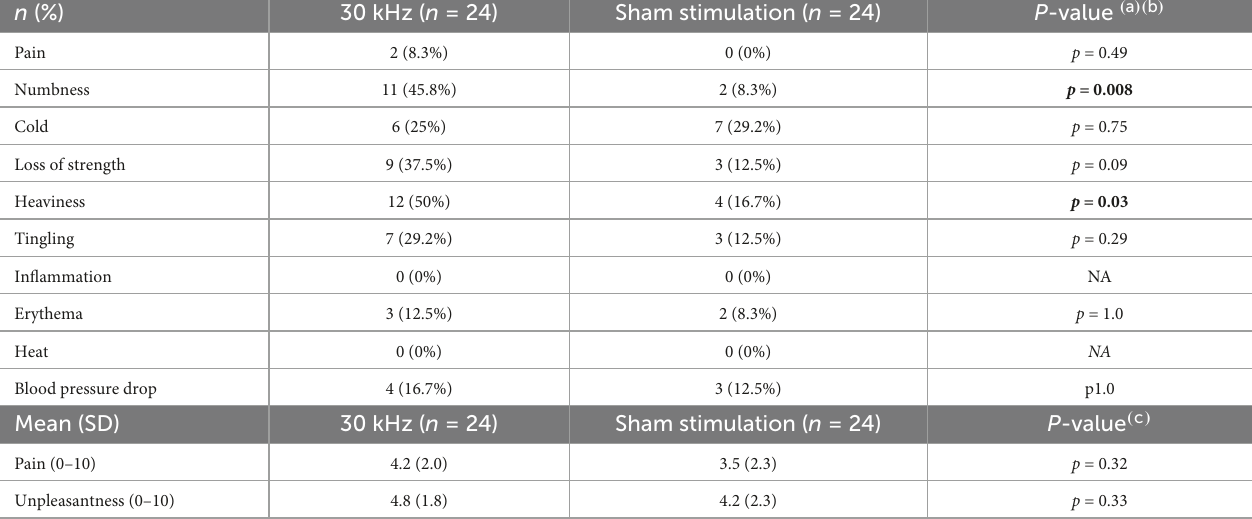
TABLE 4 Subjective perception by the